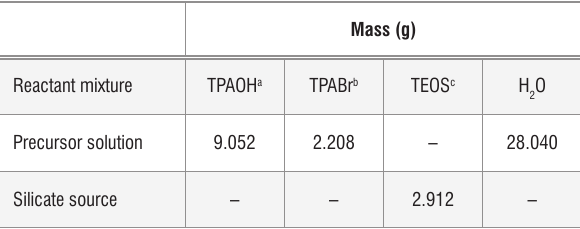
Reactant mixture compositions for the mordenite framework inverted (MFI) clear solution